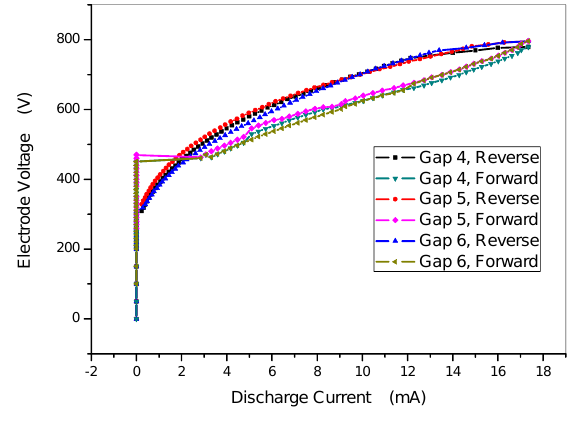
Figure 8: V − I characteristic and hysteresis for similar gaps ( d/r = 5).